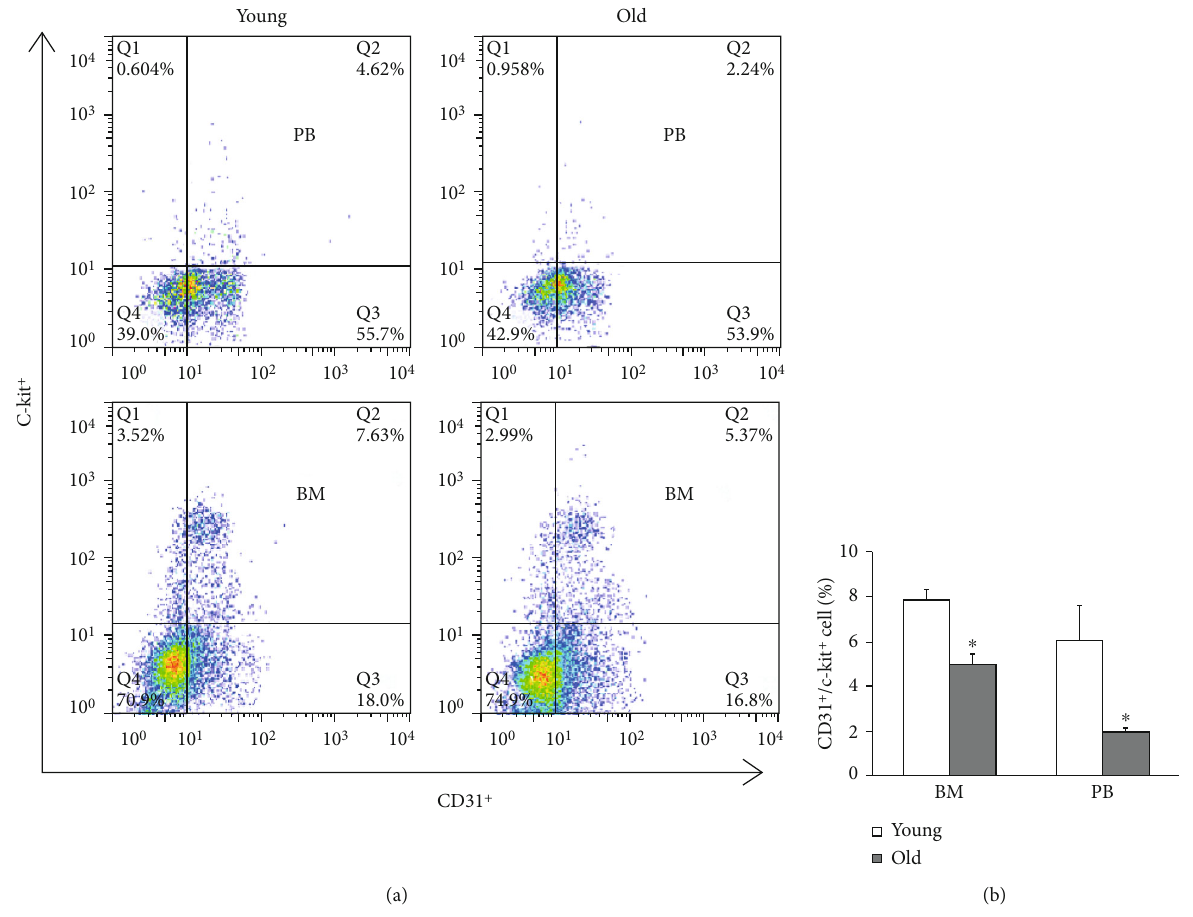
Figure 2: Aging impairs bone marrow endothelial progenitor cell (EPC) mobilization in CatK +/+ mice. (a, b) On operative day 7, representative fl ow cytometry plots and quantitative analysis results of the numbers of EPCs in bone marrow (BM) and peripheral blood (PB) of young and old CatK +/+ mice (counted total 2 × 10 4 MNCs). Data are mean ± SEM ( n = 6 ). ∗ p < 0 : 01 by one-way ANOVA and Tukey ’ s post hoc